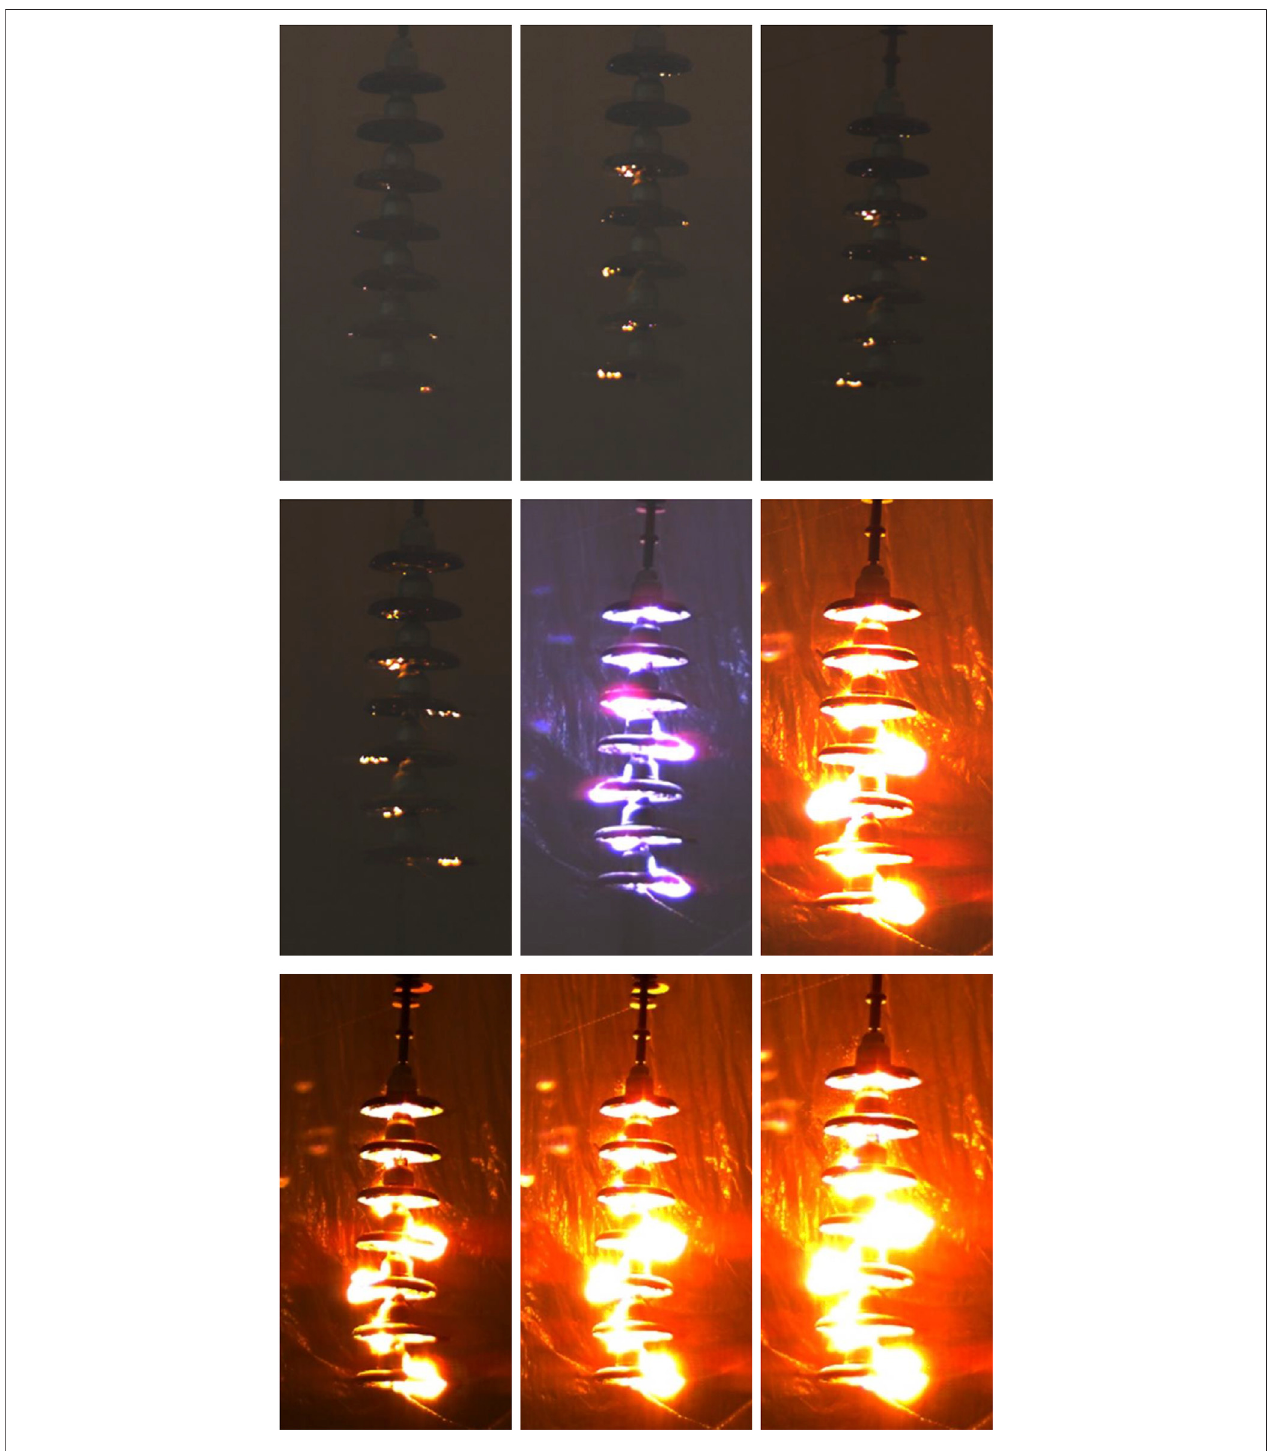
FIGURE 2 | The process of contamination discharge of